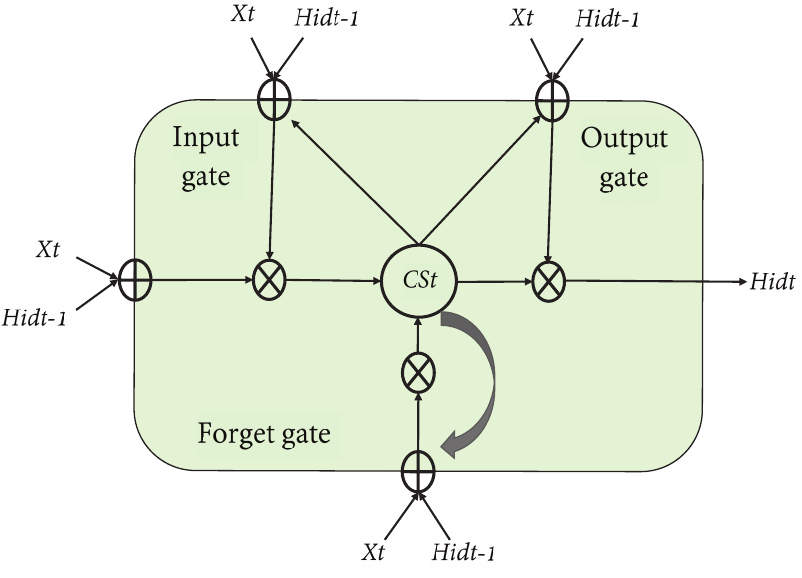
Figure 5. Structure of LSTM